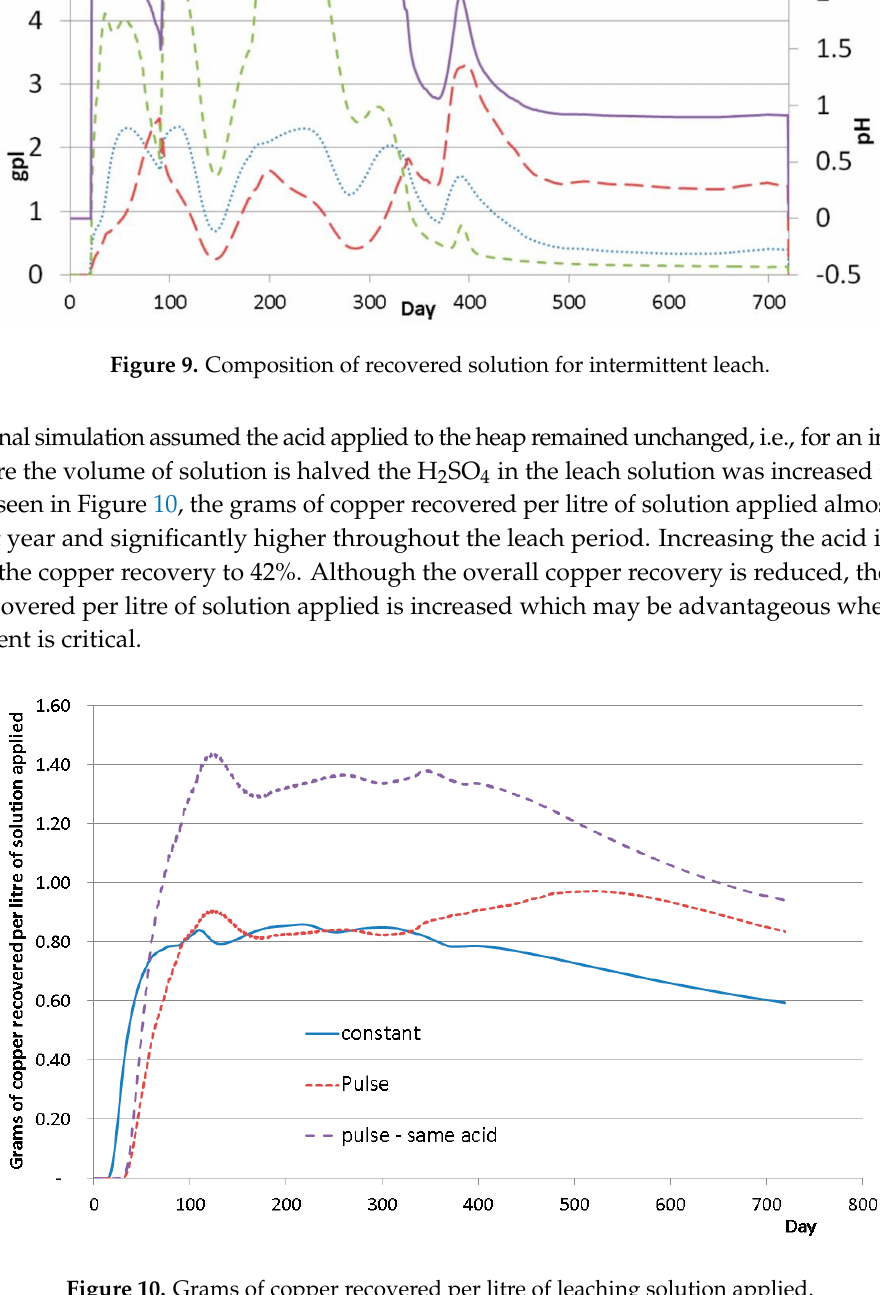
Figure 10. Grams of copper recovered per litre of leaching solution applied.